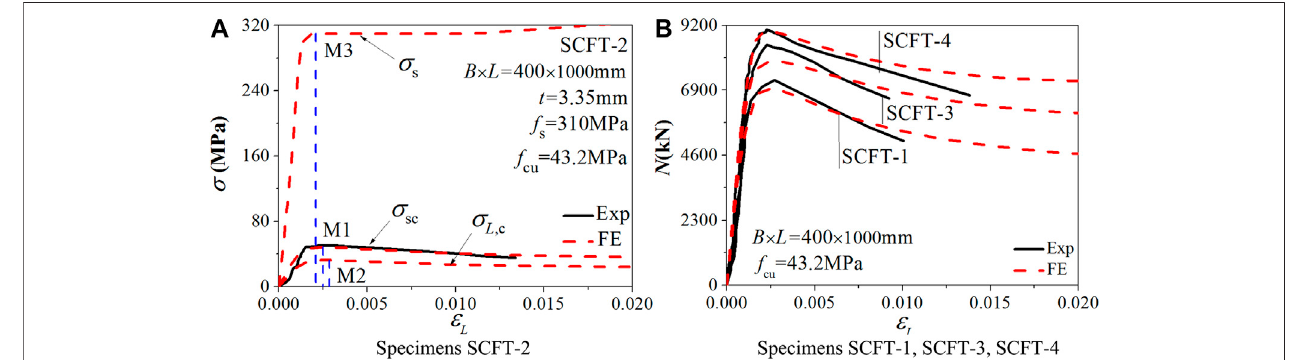
FIGURE 2 | Load (stress)-axial strain curves of stub columns under axially loading.